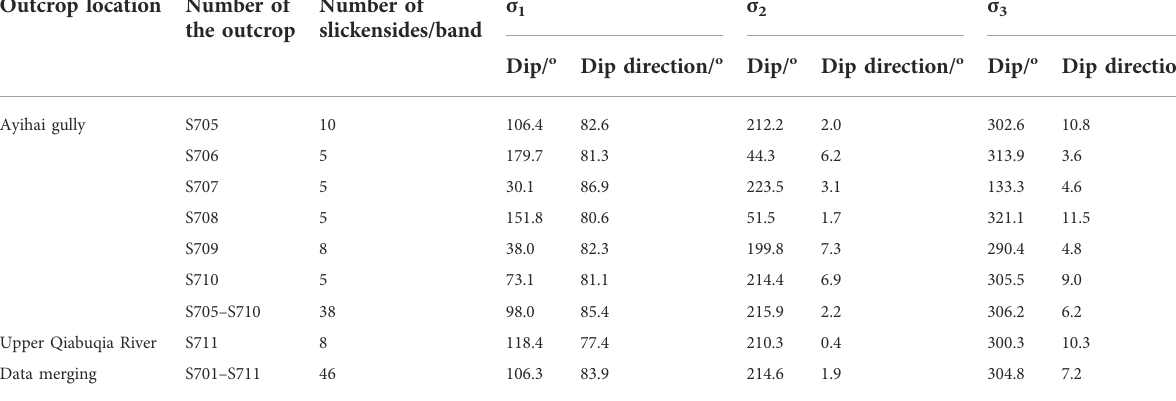
TABLE 2 Tectonic stress fi eld results for normal faults in the Qiabuqia area, as re fl ected by slickensides. Outcrop location Number of Number of σ 1 the outcrop slickensides/band